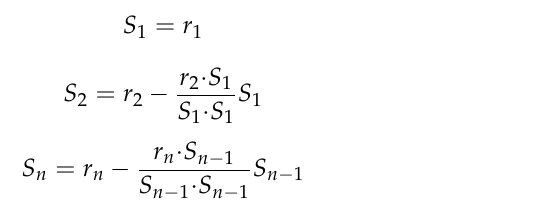
Algorithm 1 : Generation of Bio Hash Code through the Bio Hash